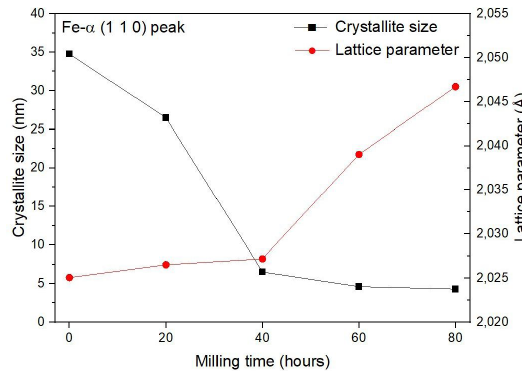
Figure 15. Crystallite size and lattice parameter as a function of different milling times for the (110) Fe-α peak for Fe-15at.%Nb samples with hexane PCA.